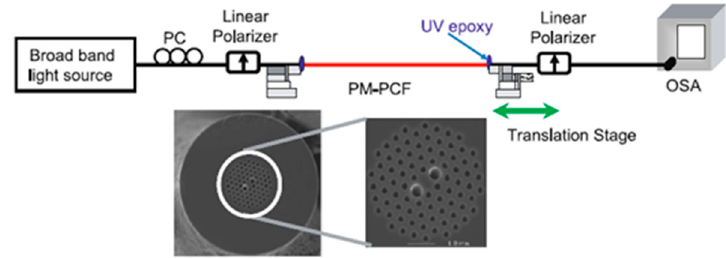
Figure 16. Experimental setup of the proposed temperature-insensitive polarization-maintaining PCF strain sensor and SEM image of the fiber (Reproduced from [69], with the permission of Springer publishing).